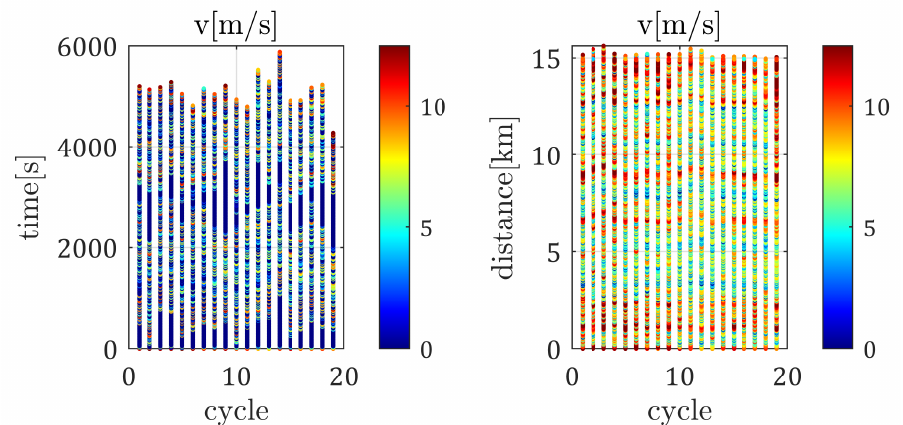
Figure 1. Recorded vehicle-speed traces in time ( left plot ) and distance ( right plot ) bases along the 19 loops covered by a bus of route 2 (“Universitats-Hosp. Dr.Peset”) during two consecutive